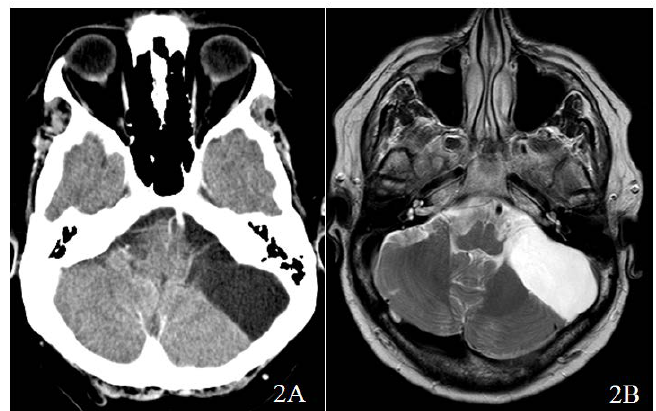
Figure 2. Head computed tomography (CT) scan showed the pre-existing cystic lesion in the left cerebellopontine angle with a slight right brainstem deviation, without associated edema ( 2A ), as confirmed by magnetic resonance imagining (MRI) ( 2B